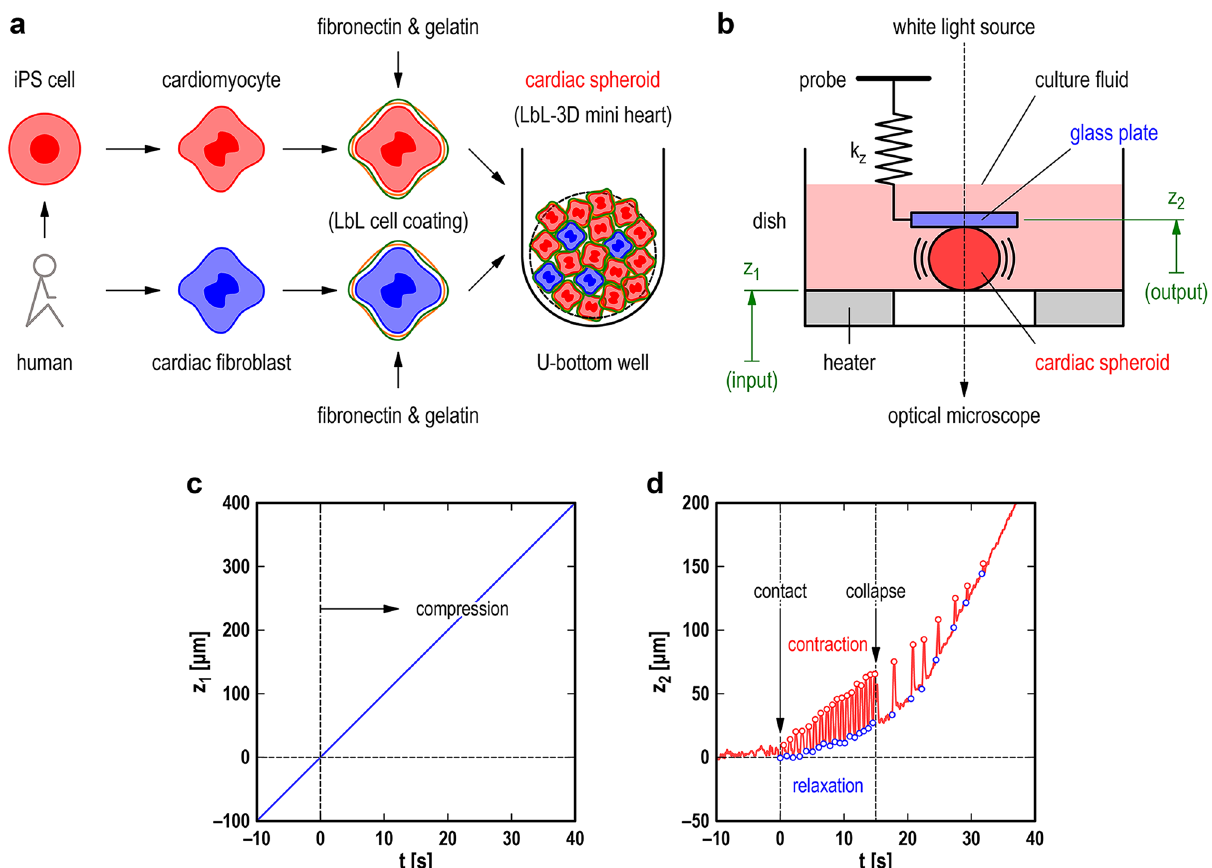
Figure 1. The mechanical response of a single cardiac spheroid (CS) to increasing compression. ( a ) A CS was fabricated by assembling human induced pluripotent stem cell-derived cardiomyocytes and human cardiac fibroblasts in a U-bottom well via layer-by-layer cell coating of fibronectin and gelatin. ( b ) A transparent polystyrene dish in which a CS was immersed in a culture fluid at a controlled temperature of 37 °C by a heater was lifted upward at a predetermined constant speed V z (= d z 1 /d t ). At t = 0, the CS made contact with two horizontal surfaces: the dish surface and the glass plate surface, where the glass plate (diameter: 1.0 mm and thickness: 0.2 mm) was mounted at the tip of a flexible probe with vertical stiffness k z . The compression of the probe spring was measured under an optical microscope. ( c ) Temporal change in the vertical position of the lower surface, z 1 (as the input into the system). ( d ) Temporal change in the vertical position of the upper surface, z 2 (as the output from the system). The blue and red circles denote the local minimum (i.e., CS relaxation) and local maximum (i.e., CS contraction), respectively. Experimental conditions: D = 340 μm ( N cell ~ 8000), k z = 3.4 N/m, and V z = 10